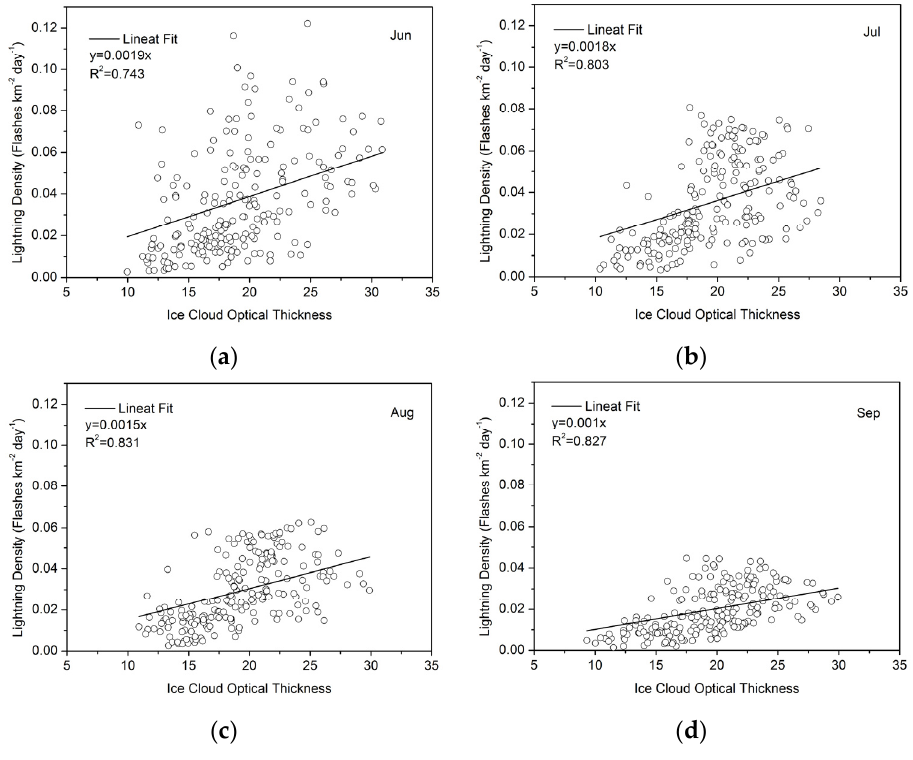
Figure 5. Correlation between lightning flash density (flashes km –2 ·year –1 ) and ice cloud optical thickness for June to September over China . ( a ) June; ( b ) July; ( c ) August; ( d ) September.